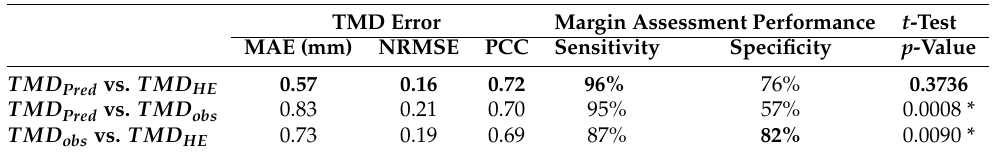
Table 4. Tumor margin distance errors, margin assessment performance, and p -values of two-sample t -tests for different comparisons of TMDs. TMD